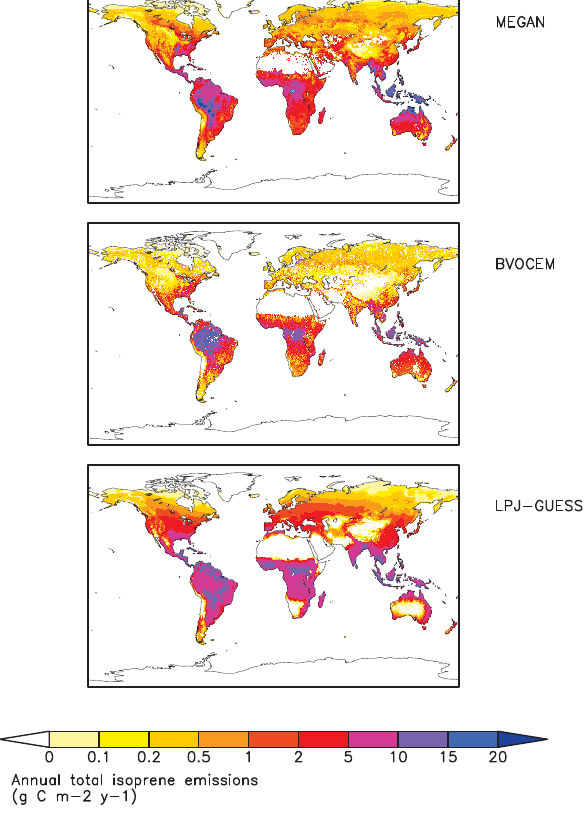
Fig. 1. Average annual global isoprene emissions for the period 1981–2002 from three different emission models. Averages are from the “standard” model setups in the case of LPJ-GUESS and MEGAN (see Table 1, Fig. 2, panels a , e ), and with CRU climate in the case of BVOCEM (Fig. 2, panel i